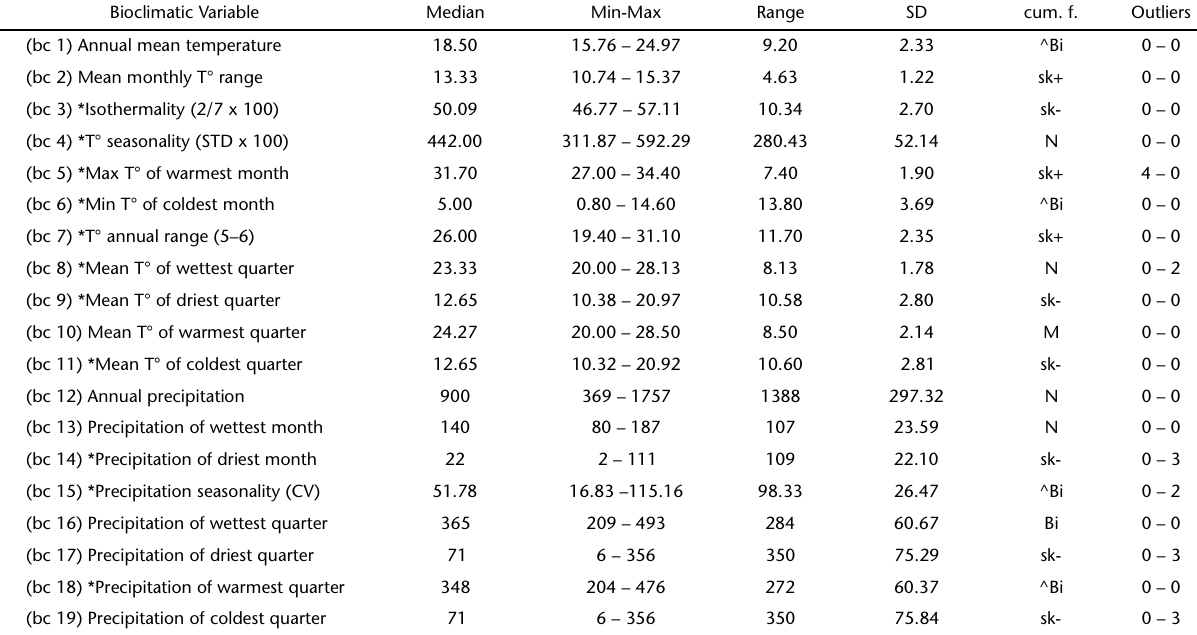
Table 1. Bioclimatic profile of Discocyrtus dilatatus (n = 85) (B IOCLIM ): basic statistics of the 19 bioclimatic variables and description of the cumulative frequency curves (cum. f.). Curves are characterized as normal (N), skewed towards the lower (sk–) or upper end (sk+), bimodal (Bi) with high peak at the right (Bi^) or at the left (^Bi) and multimodal (M); the number of extreme low (left) and high (right) outliers in the curves are provided. Temperature values are in Celsius degrees (°C), precipitation in millimeters. The 11 variables employed in the M AXENT models are